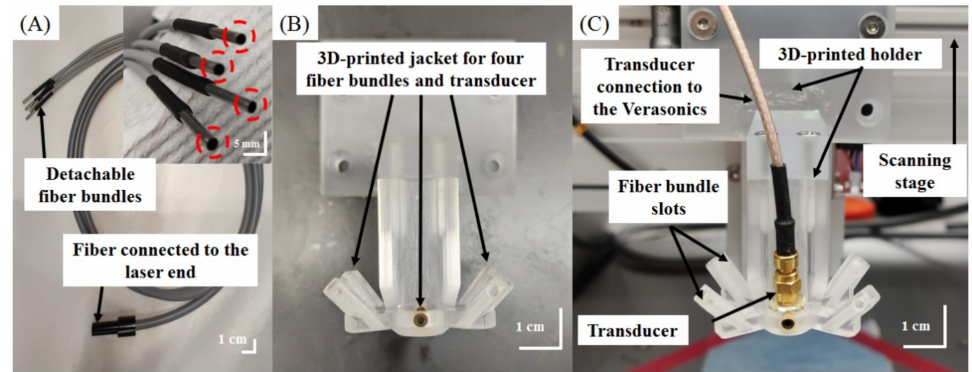
Figure 3. Photograph of our adjustable dark-field AR dual-modality US/PA imaging system. ( A ) Fiber bundle with one input end for connection to the laser and 4 output ends. ( B ) 3D-printed jacket for 4-fiber bundles and the transducer. ( C ) Photograph of the transducer and jacket, which were fixed to a homemade scanning